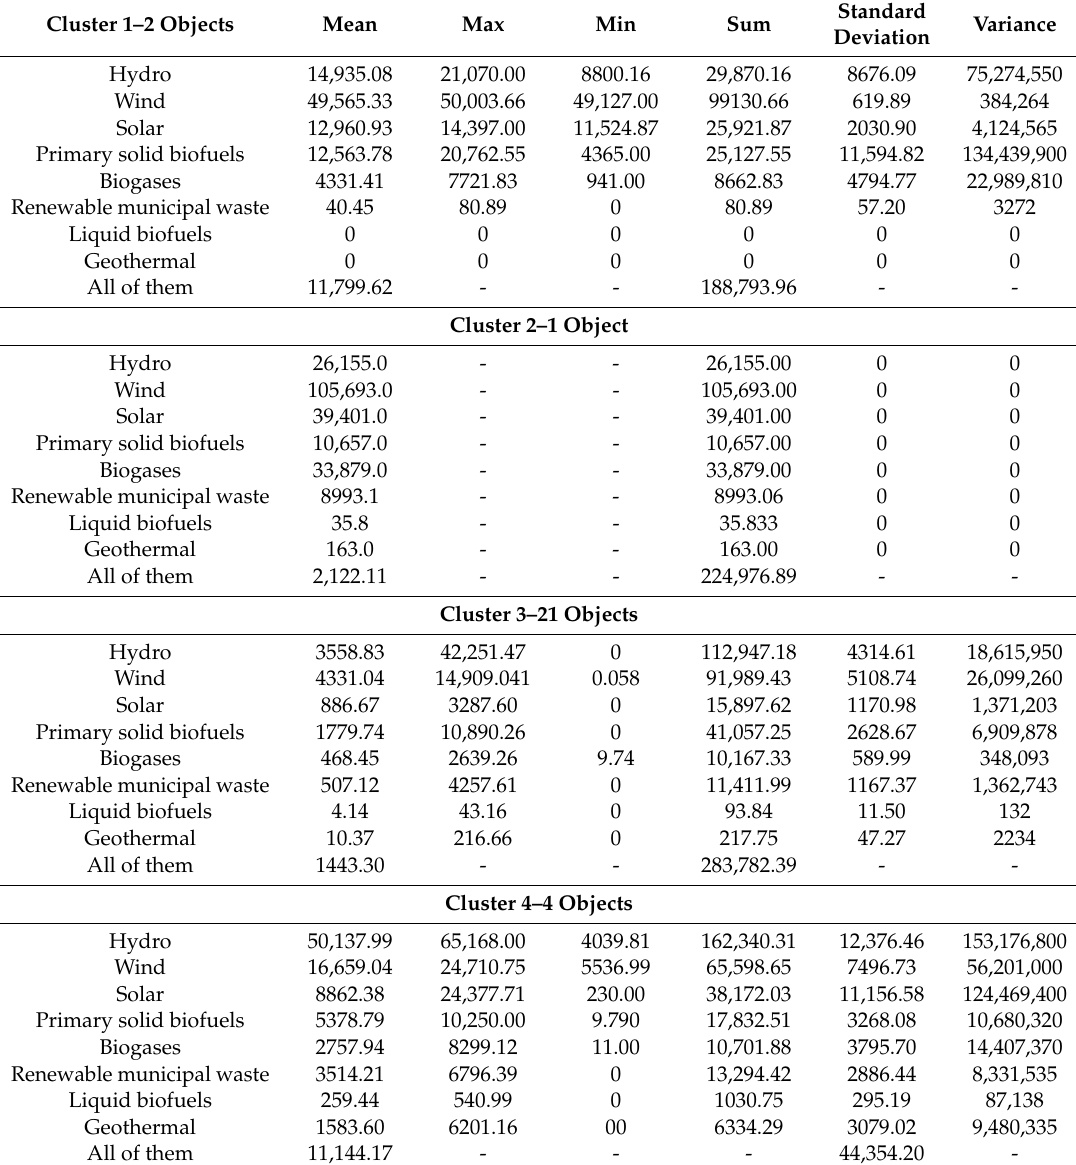
Table 15. Elements of clusters with distances from centers (own